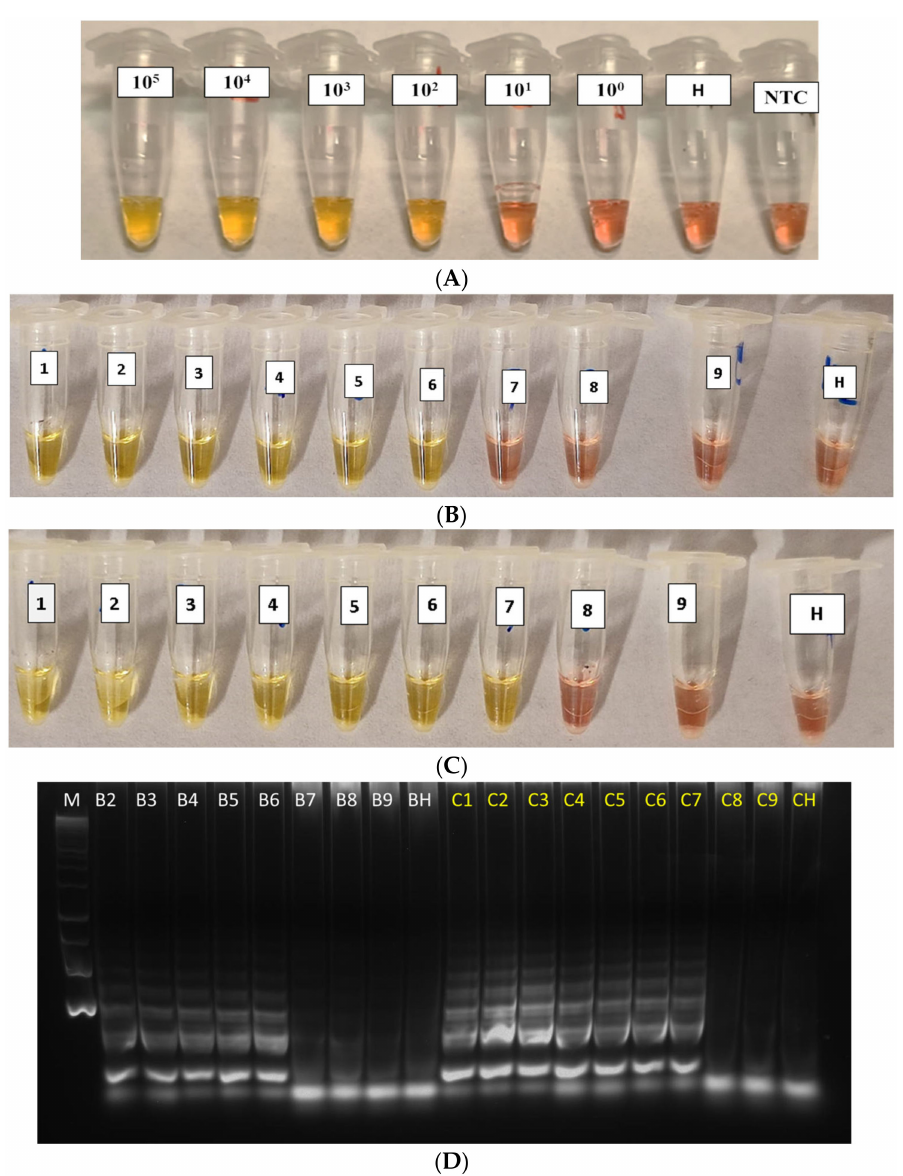
generate clear positive reactions.